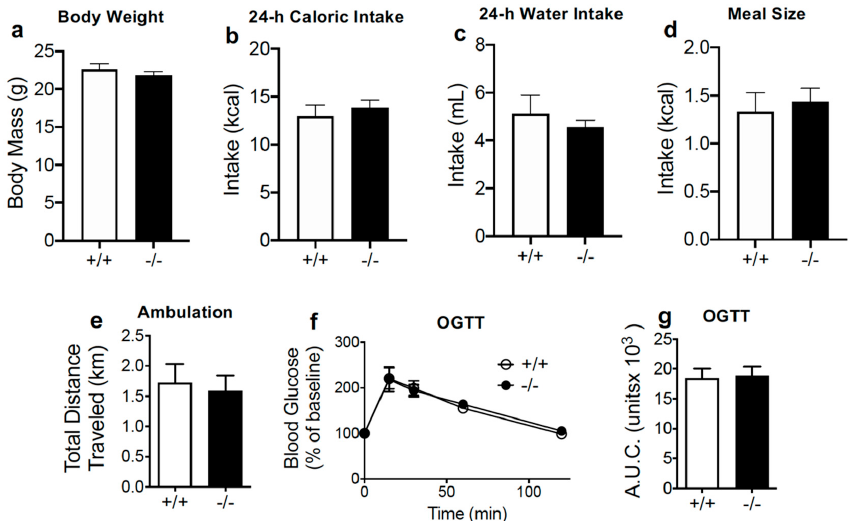
Figure 4. Conditional intestinal epithelium CB 1 R-deficient mice display no changes in baseline feeding parameters, motor activity, or glucose clearance. Unpaired Student’s t -test, two-tailed ( a – e , g ; p > 0.05); two-way Repeated Measures ANOVA with Holm-Sidak’s multiple comparison tests ( f ; not significant). Results are expressed as means ± S.E.M; n = 7–8 per condition ( a – e ), n = 3–4 ( f – g ). +/+ = IntCB 1 +/+ mice, − / − = IntCB 1 − / − mice; OGTT = oral glucose tolerance test; AUC = area under the curve.